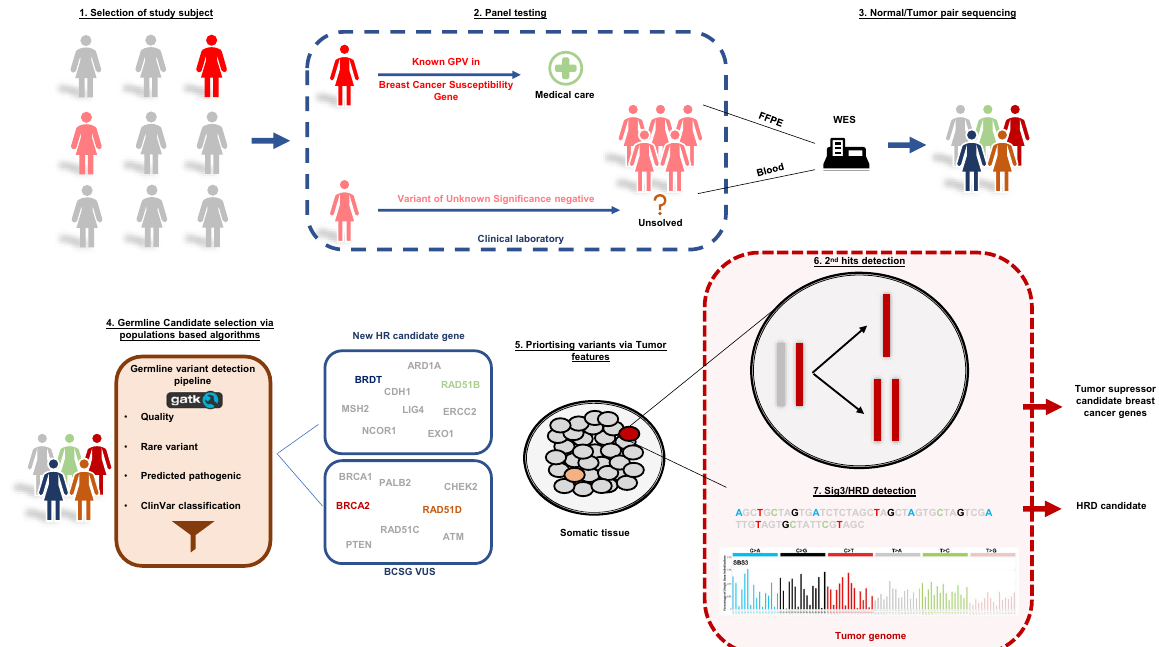
Fig. 1 Study work fl ow. (1) all eligible women were selected based on their personal and family history of cancer (red and pink women) and (2) received prior clinical screening. (3) unsolved cases were selected for WES through normal/tumor pair samples from blood lymphocytes and FFPE tissues. (4) sequencing data were analyzed through a germline candidate variant detection algorithm focused on homology- directed repair candidates following a classical BCSG model. (5) tumor landscapes were evaluated through a variant calling pipeline designed to minimize artifacts and a second-hit detection strategy based on the biological mechanism (i.e. defects in the hr pathway). (6) candidate BCSGs were re-evaluated in the context of a patient harboring a germline variant with an HRD tumor and second